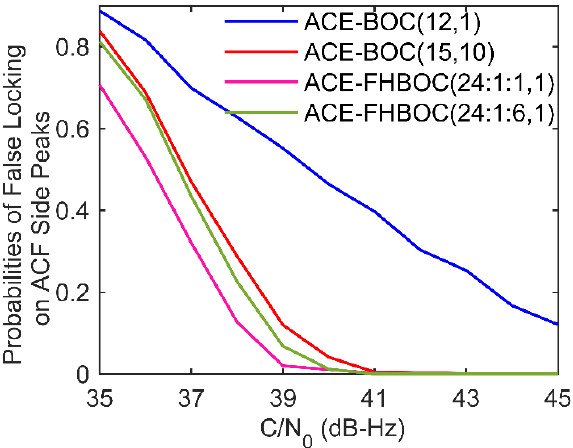
Figure 13. Probabilities of false locking on ACF side peaks for the example signals.